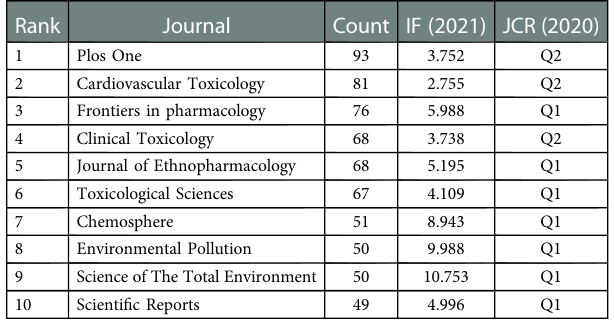
TABLE 4 Top 10 journals related to cardiotoxicity.